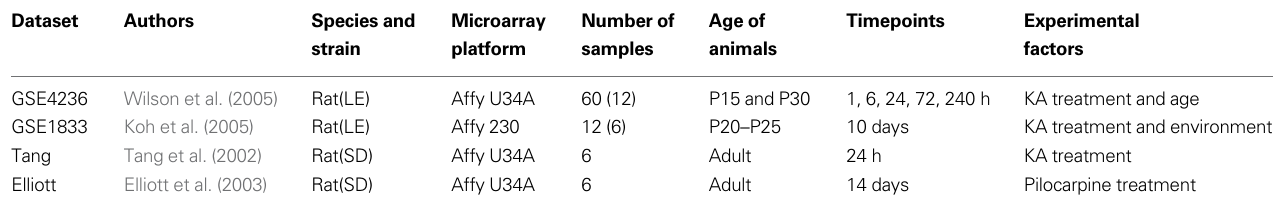
Table 1 | Microarray datasets used in the study. The microarray experiments were conducted on two different strains of rats: Long Evans (LE) and Sprague Dawley (SD). The total number of samples in the dataset is shown, while the number in parenthesis indicate how many samples were used for the meta- analysis. All experimental animals were male and the administrated doses of excitotoxins were 10 mg/kg for KA and 340 mg/kg for